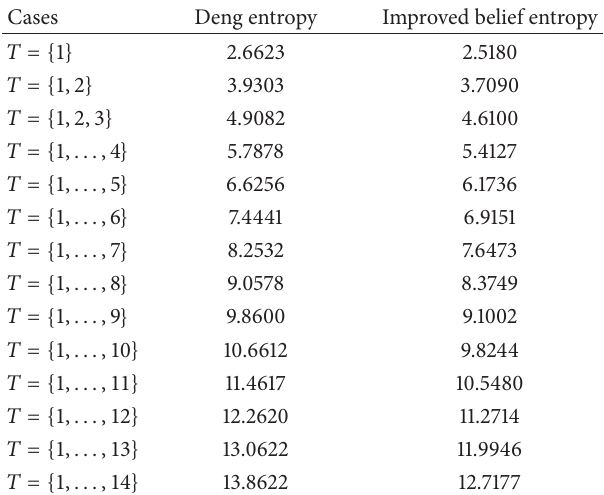
Table 3: Improved belief entropy with a variable element number in 𝑇 .